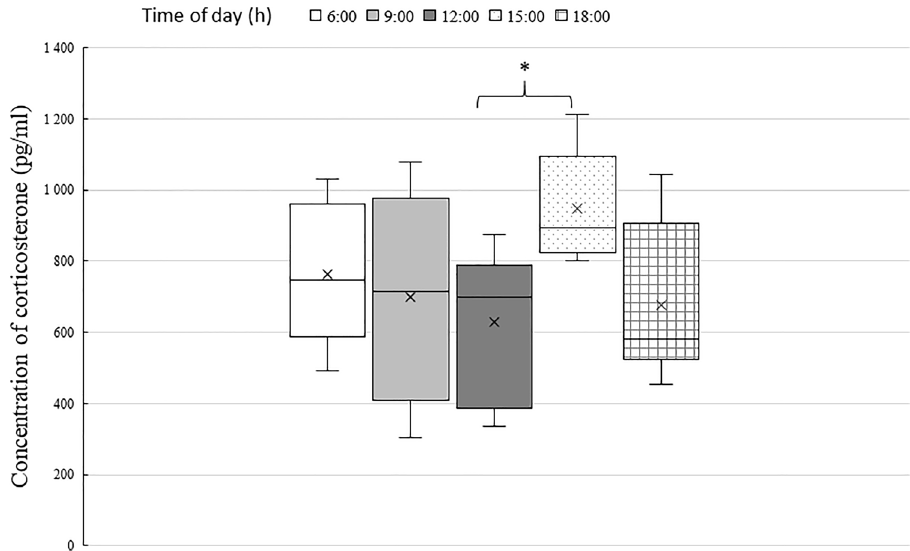
Figure 1. The daytime fluctuation of the salivary corticosterone concentration in six rabbits. Three replicate samples were taken and analysed at each point in time. a,b The values with different superscript letters are significantly different (p <